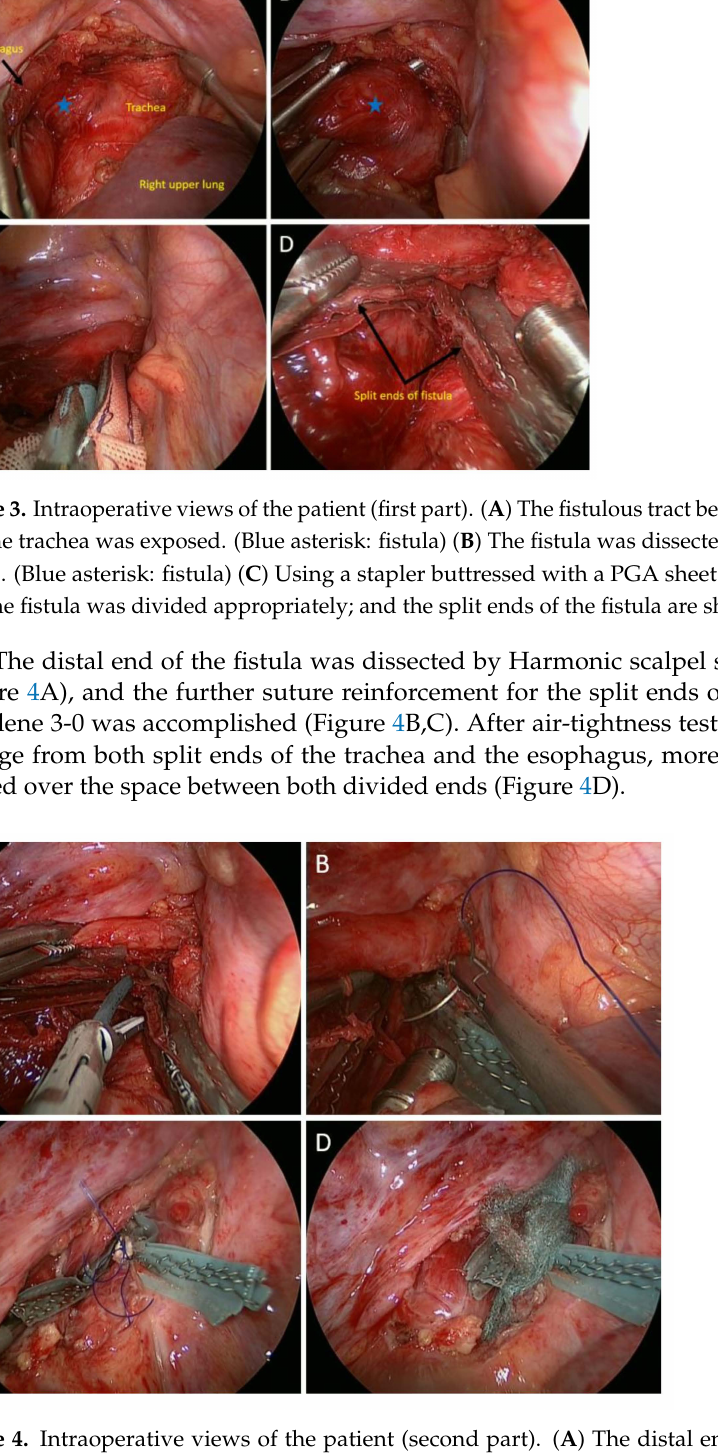
Figure 4. Intraoperative views of the patient (second part). ( A ) The distal end of the fistula was dissected by Harmonic scalpel scissor thoroughly; ( B , C ) Suture reinforcement for the split ends of the trachea with Prolene 3-0 was performed; ( D ) Additional PGA sheets were packed over the space between both divided